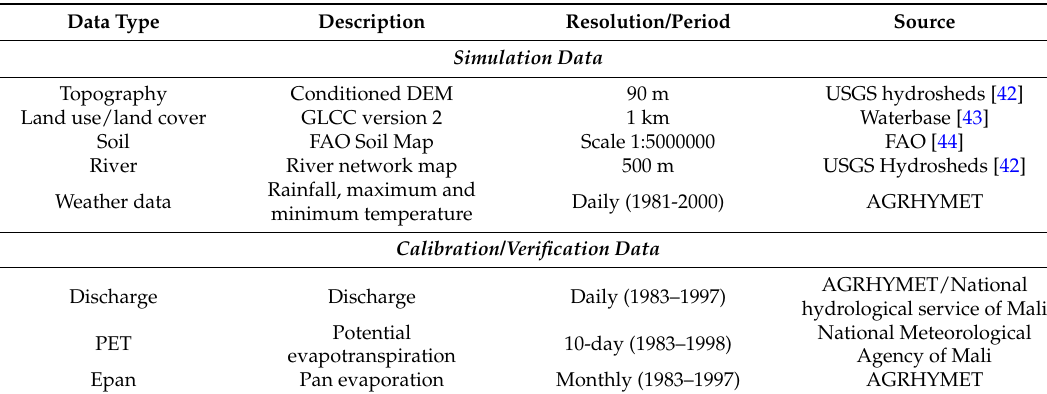
Table 1. Input data of the SWAT model for the Bani catchment.